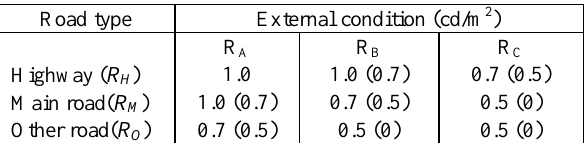
intensity by road in mesh n . Figure 4 shows a road grid map of road distribution in Tohoku region.